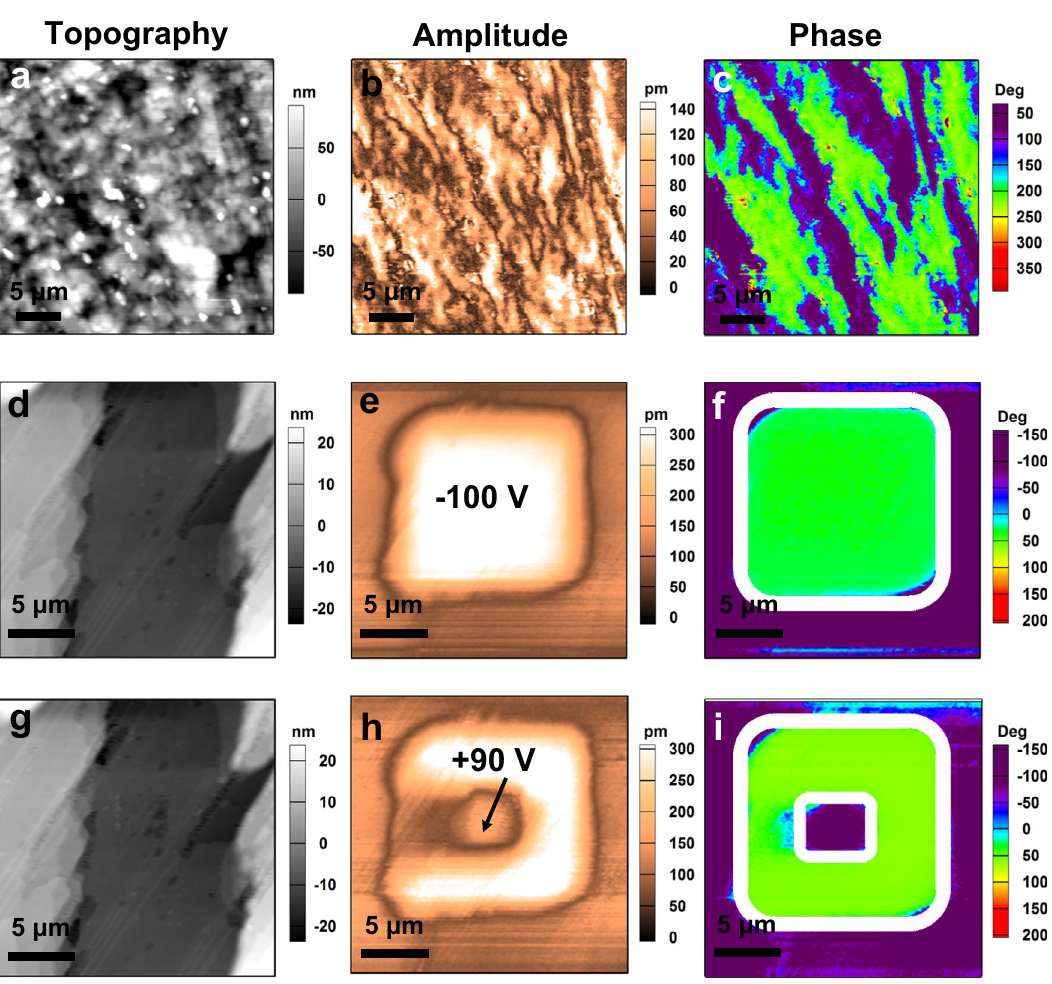
Fig. 5 | PFM characterization of 4I-CASS in phase I. a – c Topographic ( a ), lateral PFM amplitude ( b ), and phase ( c ) images mapped on the spin-coating thin fi lm. d – f Topography( d ),verticalPFMamplitude( e )andphase( f )imagesafterapplying a tip voltage of − 100V in the center area of a region with an initial state of a single domainstate. g – i Topography( g ),verticalPFMamplitude( h ),andphase( i )images after applying +90V tip voltage in the center region of the switched domain. The